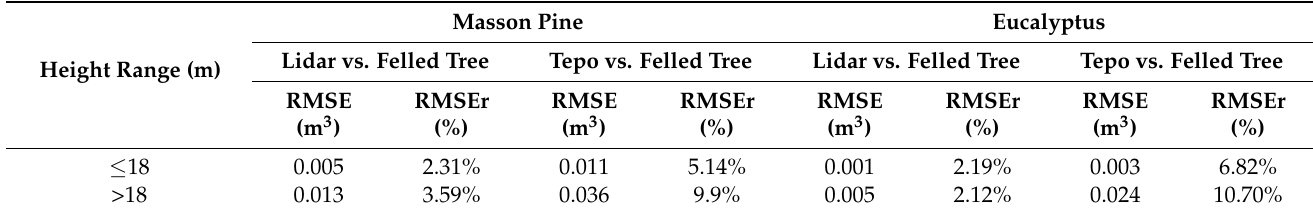
Table 8. Evaluation of single-tree volume results based on different height ranges. Masson Pine Height Range (m)